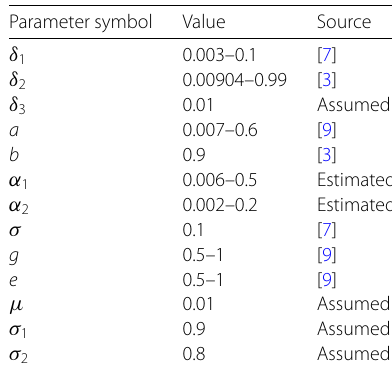
Figure 2 Effect of recovery rate on pneumonia infectious population